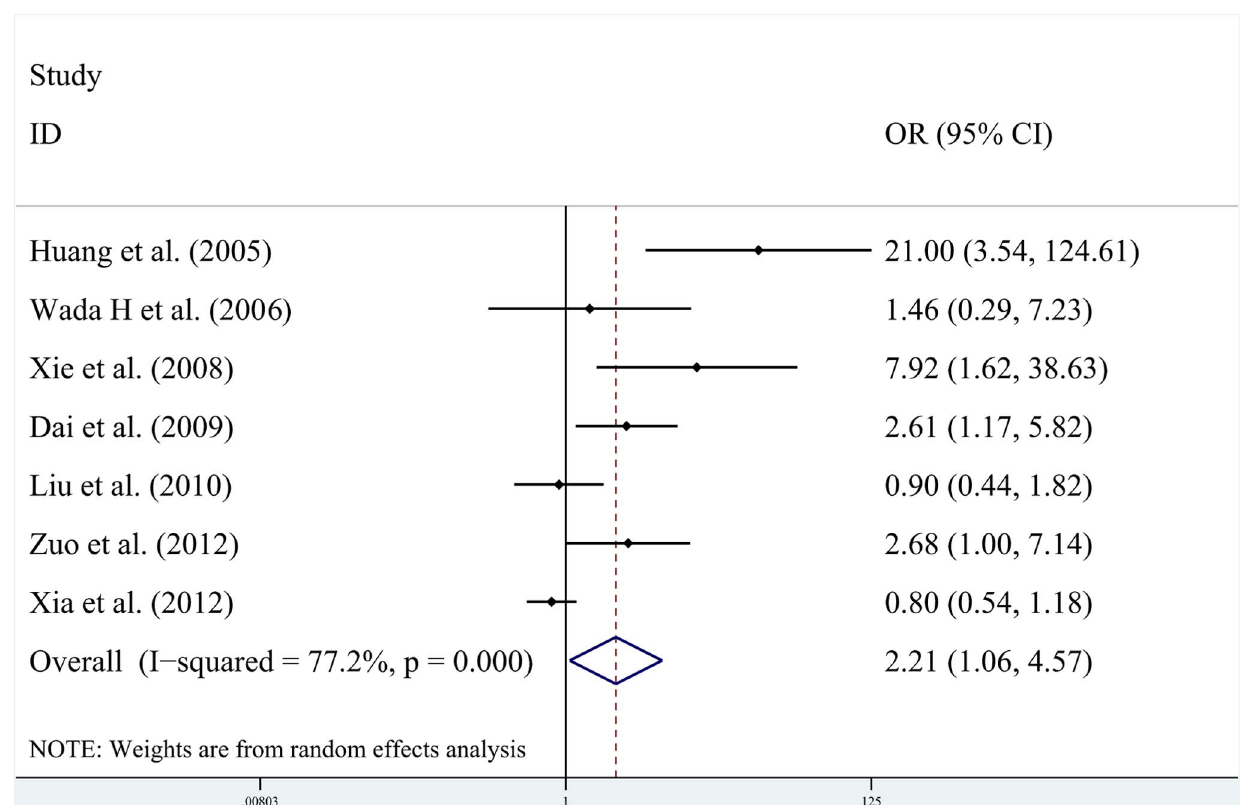
Figure 4. Plot illustrates findings from meta-analysis of the association between HIF-1 a overexpression and tumor vascular invasion in 7 trials. Each study was shown by the name of the first author and the OR with 95% CIs. The summary OR and 95% CIs were also shown (according to the random effect estimations).